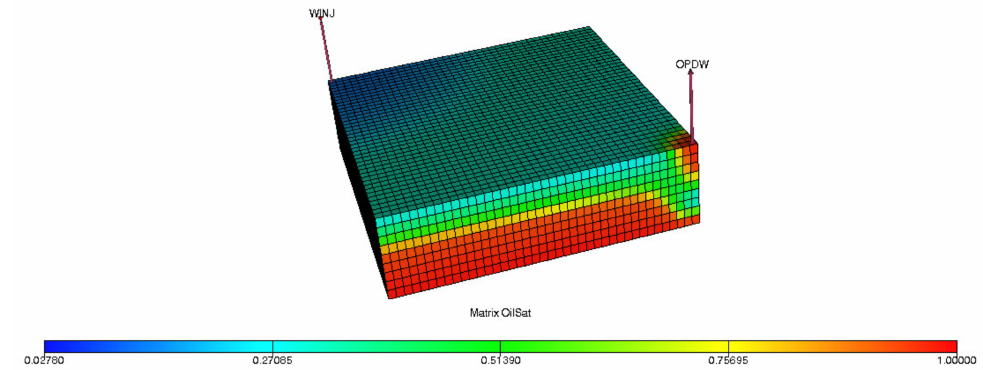
Figure 7. Schematic of fluid saturation during gas injection; read: oil bank, blue: gas.